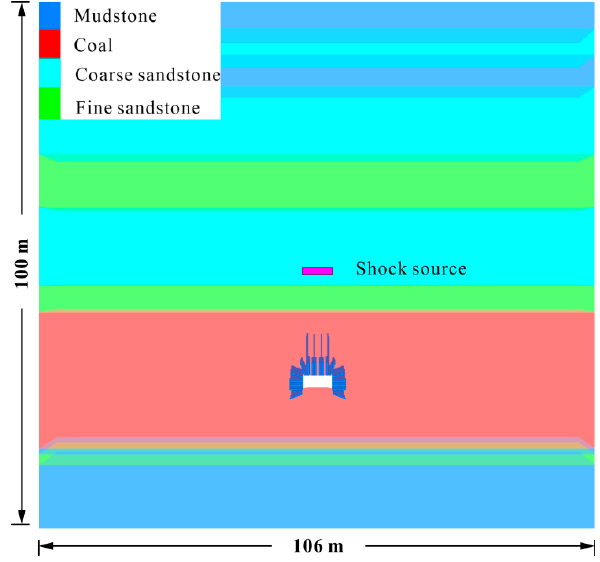
Figure 4. Numerical model.